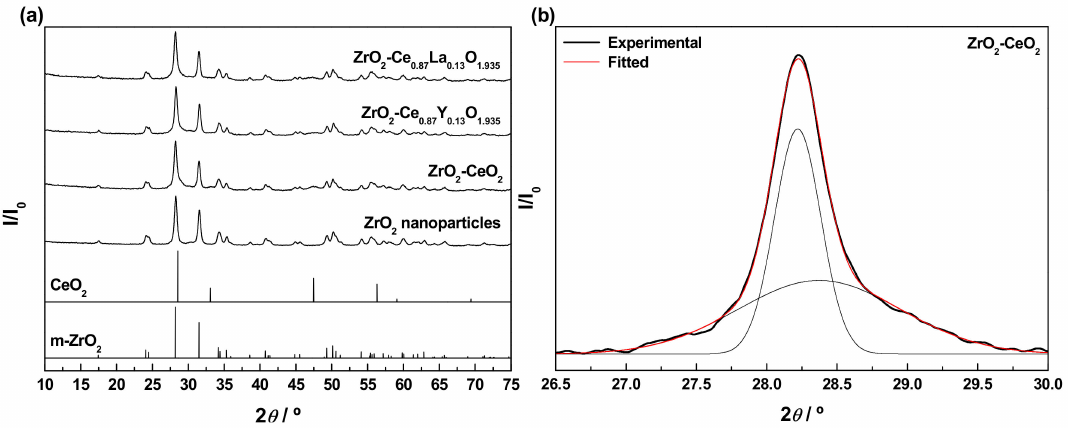
Figure 2. ( a ) XRD patterns recorded for the commercial ZrO 2 nanoparticles and the fresh undoped and Ln-doped ZrO 2 -CeO 2 samples, and ( b ) fitted and experimental diagrams of the di ff raction peak, centred at around 28.2 ◦ for the fresh ZrO 2 -CeO 2